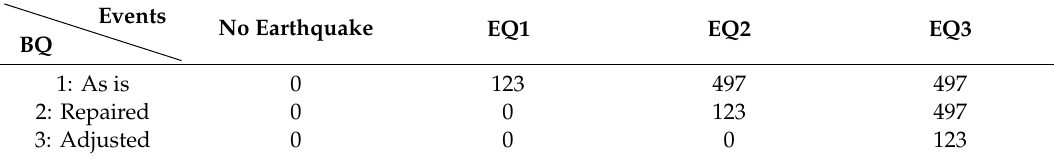
Table 9. GWP in kg CO 2 / m 2 due to seismic event occurrence and building quality.